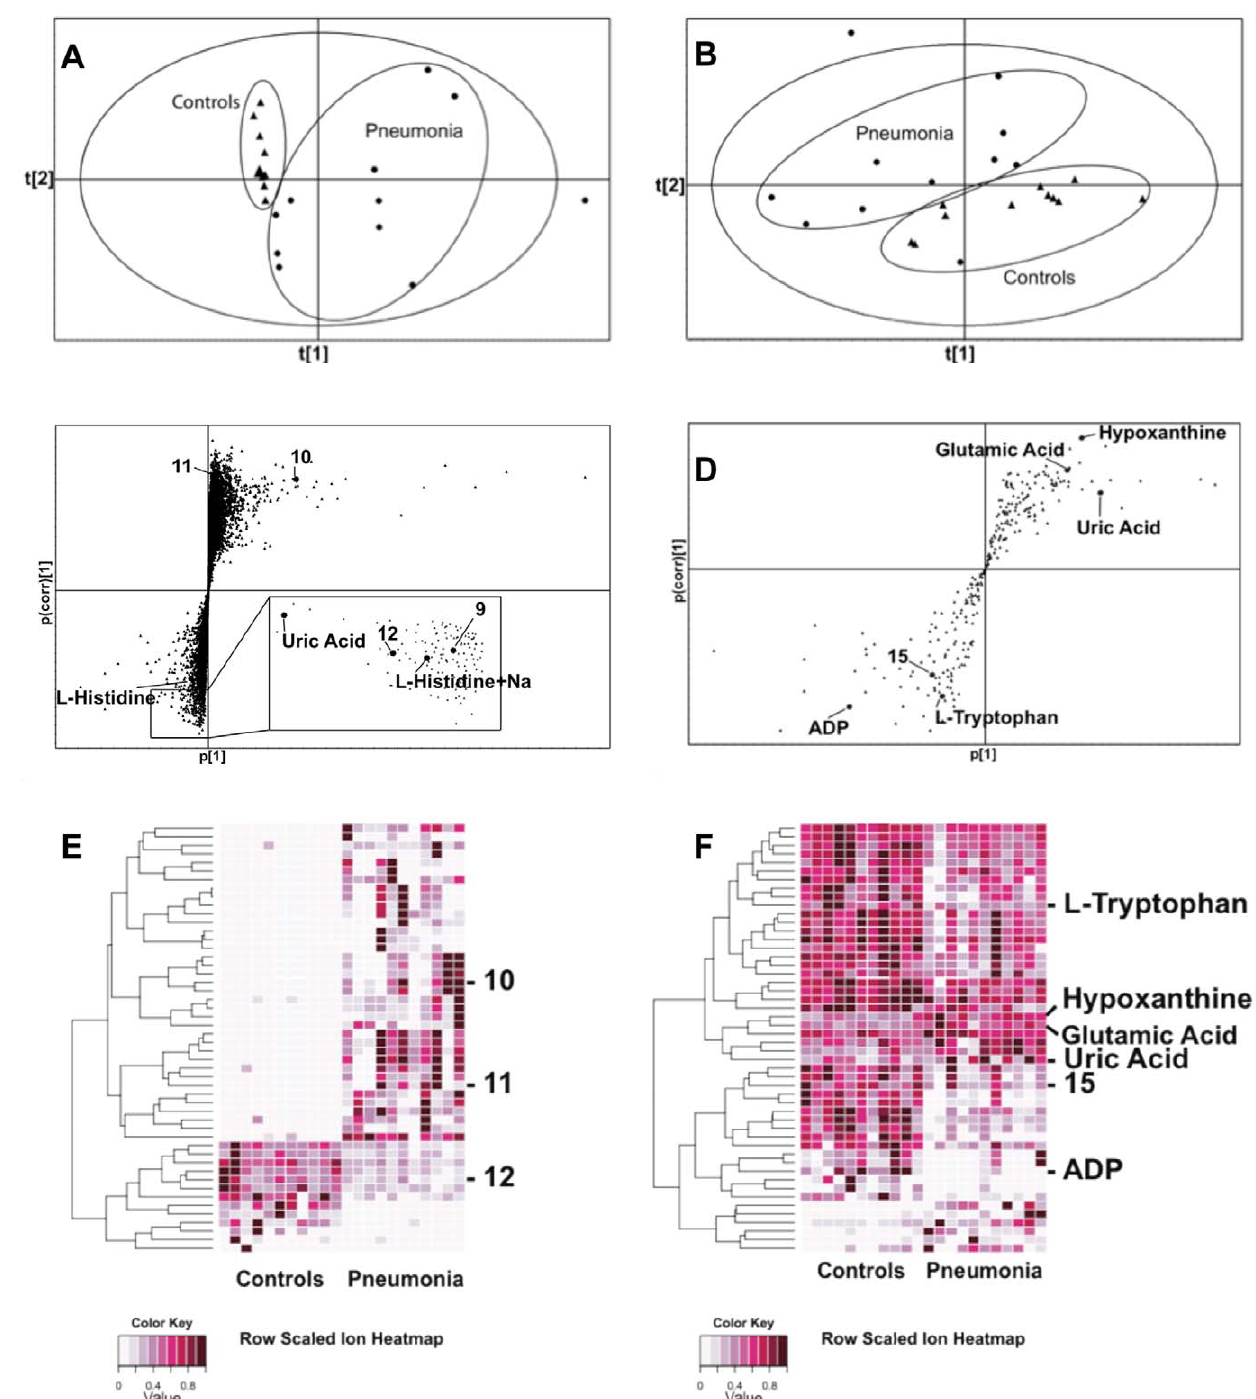
Figure 2. Analysis of the control and pneumonia samples utilizing SIMCA-P + and Random Forests revealed differences in ion abundance between the two groups. Panels A and B show PCA scores plots for urine (ESI + mode) and for plasma (ESI - mode), respectively. PCA analysis is an unsupervised method of extracting information, where the classes (i.e. experimental groups) are unknown. Panels C and D show the S- plots constructed from the supervised OPLS analysis of urine (ESI + mode) and plasma (ESI- mode) respectively. Ions with the highest abundance and correlation in the pneumonia group with respect to the controls are present on the upper far right hand quadrant, whereas ions with the lowest abundance and correlation in the pneumonia group with respect to the control group are residing in the lower far left hand quadrant. Ions are marked with either their identity or a number corresponding to Table 1. Panels E and F show heatmaps for urine (ESI + mode) and plasma (ESI- mode) respectively. The heatmaps were constructed based on the top fifty metabolites of importance, which were extracted with Random Forests analysis. Variable differences are revealed between the control and pneumonia groups, with verified and unknown ions marked on the right corresponding to Table 1. The parallel analysis of the samples with SIMCA-P + and Random Forests allows for the ability to verify that ions, which are identified through both ways (i.e. hypoxanthine), are highly significant, as depicted through two completely different algorithms. Additionally, it allows for the increase of the numbers of ions that are potential candidates for biomarkers.